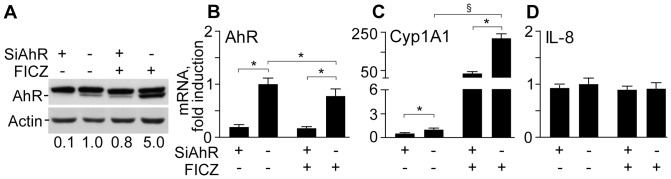
Effects of AhR silencing (SiAhR) on metabolic system and IL-8 expression in NHEK.A. AhR levels in NHEK treated for 24 h with 1 µM FICZ. The treatment was started 48 h after initiation of RNA silencing of AhR (SiAhR) or mock (-). The mean values of the densitometry of AhR bands (three independent determinations) are reported. Levels of AhR (B), Cyp1A1 (C) and IL-8 (D) transcripts in NHEK treated for 24 h with 1 µM FICZ. *P<0.05 and §P<0.01.